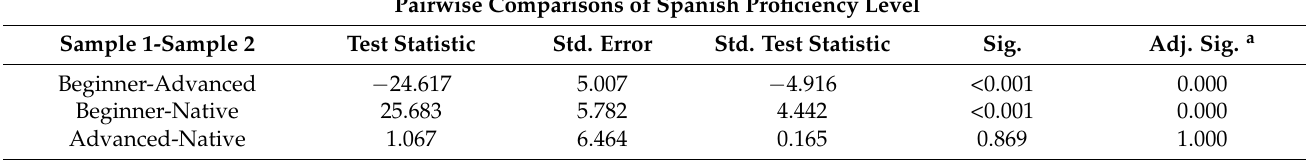
Table A6. Pairwise Comparisons table for Task